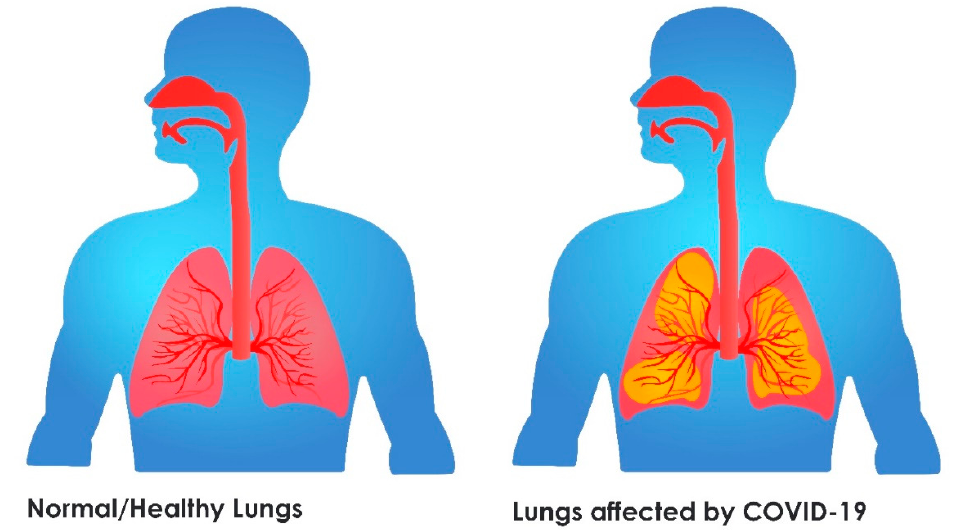
Figure 1. Pictorial representation of normal and COVID-19 affected lungs. Approximately one-fifth of infected cases develop lower respiratory tract infection, and these patients present with acute respiratory distress syndrome (ARDS). Histologically, this stage reveals lung sequestration along with host cell apoptosis. Persistent inflammation and diffuse alveolar damage are common histopathologic patterns observed among the infected patients exhibiting ARDS [5,10].